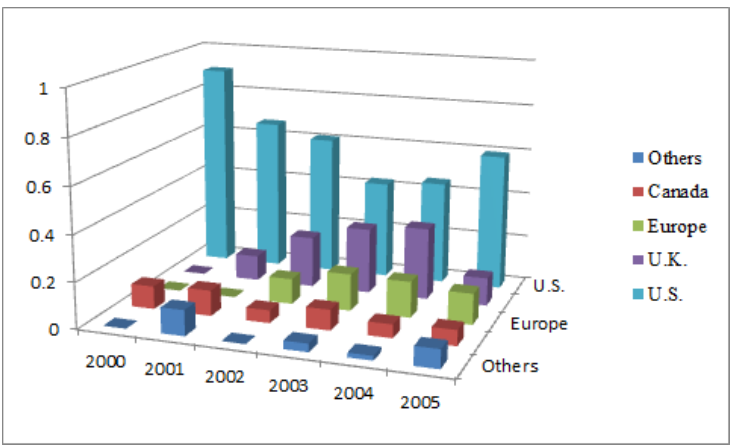
Figure 5. Geographic distribution of OA authors in LIS journals by major country or region